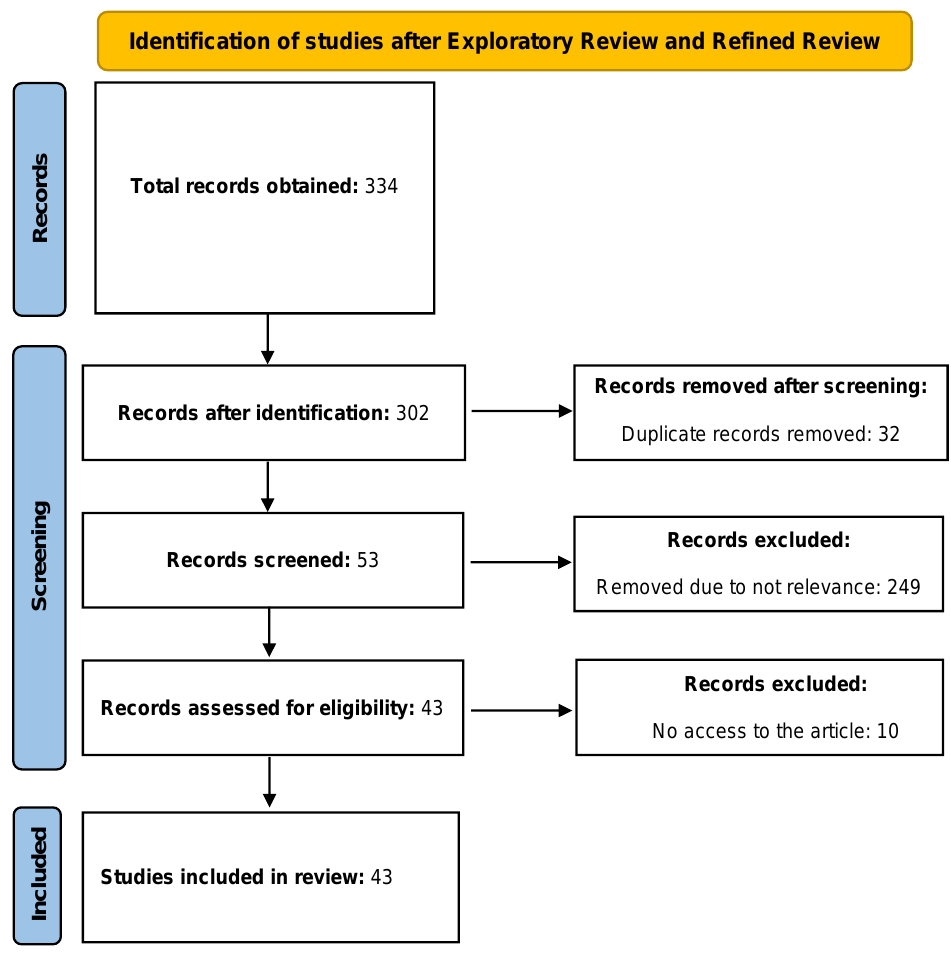
Figure 7. PRISMA flow diagram of record selection according to [67].